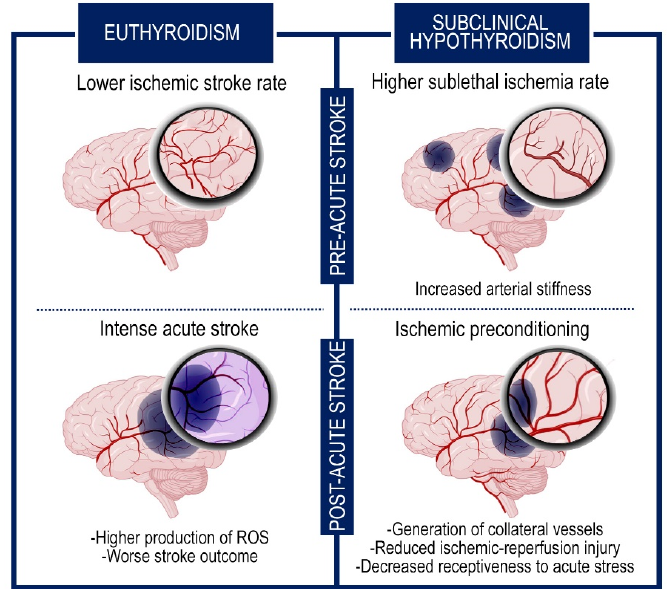
Figure 2. The subclinical hypothyroidism exerts neuroprotective effects through an ischemic precon- ditioning system. Graphic representation of the brain in subclinical hypothyroidism and euthyroid condition. The figure shows the events that occur before and after the intense ischemic accident. The subclinical hypothyroidism increases the frequency of sublethal ischemia but ameliorates the subsequent response to acute cerebral stroke for the generation of collateral vessels and the hypometabolic